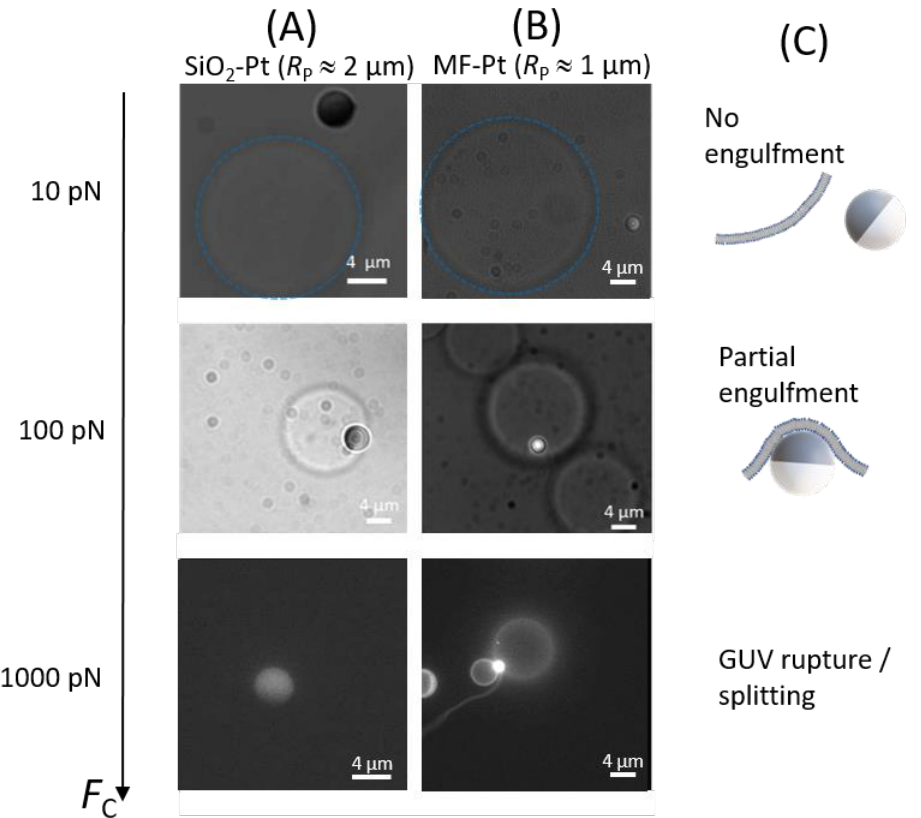
Figure 3. Bright field and fluorescence microscopy images of: ( A ) SiO 2 –Pt Janus colloids ( R P ≈ 2 µ m) and ( B ) MF–Pt Janus colloids ( R P ≈ 1 µ m) interacting with POPC GUVs at given centrifugal forces F C . Images are taken from below. Dashed blue circles are guides to identify the vesicles. ( C ) Sketches of a Janus colloid non-interacting with a membrane at F C ≈ 10 pN, and a Janus colloid partially engulfed by a GUV membrane at F C ≈ 100 pN. For F C ≈ 1000 pN, the number and the size of GUVs dramatically decreased due to GUV rupture and splitting.